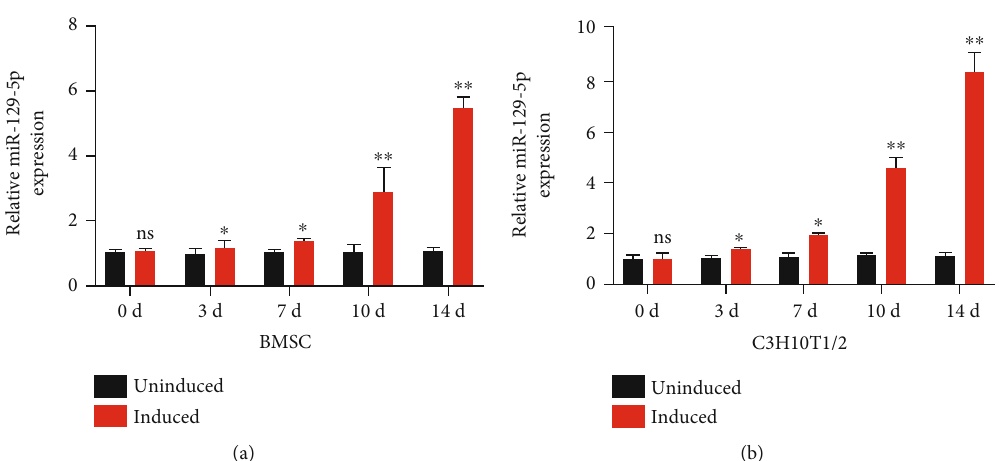
Figure 1: miR-129-5p expression is induced in BMSCs and C3H10T1/2 during osteogenic di ff erentiation. BMSCs and C3H10T1/2 cells were cultured in osteogenic and normal medium. miR-129-5p expression in BMSCs (a) and C3H10T1/2 cells (b) was examined by quantitative RT-PCR at days 0, 3, 7, 10, and 14. U6 was used as an internal control. All data were expressed as means ± SD . n = 3 for each group in all experiments. ∗ p < 0 : 05 and ∗∗ p < 0 : 01